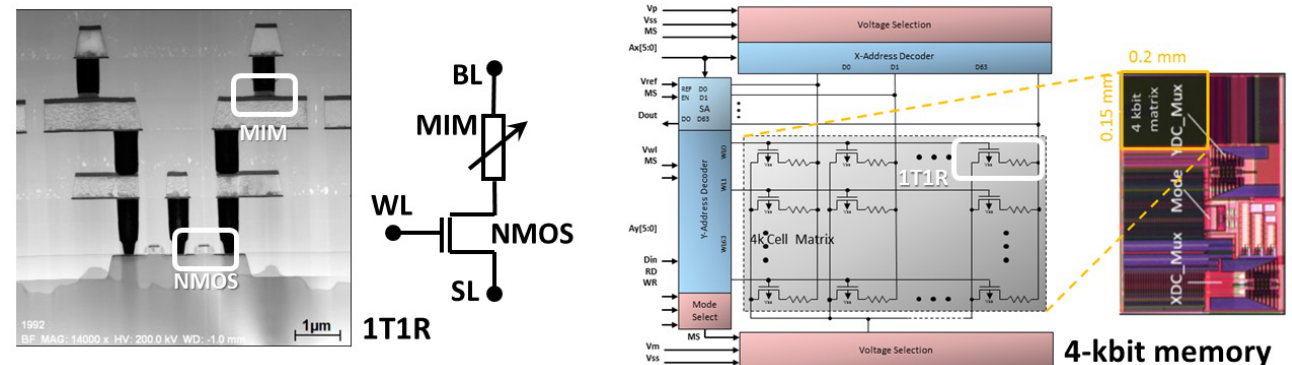
Figure 1. Cross-sectional transmission electron microscopy (TEM) image and schematic of the 1T1R memory cell ( left ) and block diagram and micrograph of the 4-kbit memory device ( right